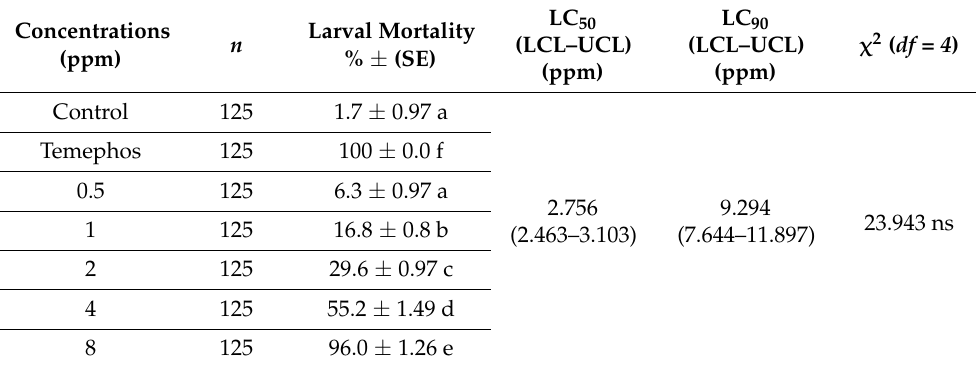
Table 3. Larvicidal activity of Hi -ZnO-NPs against the 3rd larval instar of the mosquito vector, Culex pipiens.